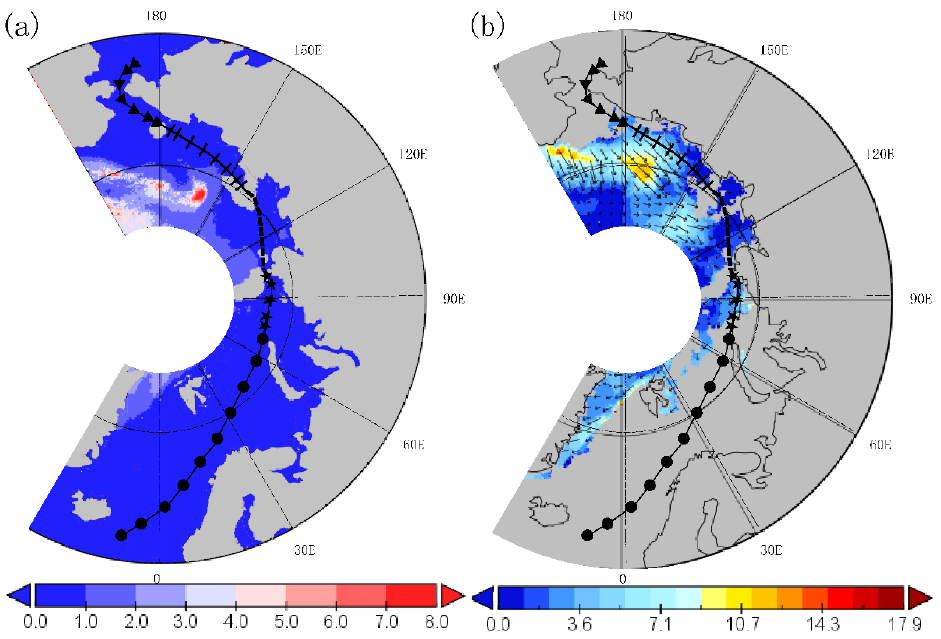
Figure 23. The sea ice age ( a ) and sea ice movement ( b ) of the NEP in the Arctic summer in 2015.